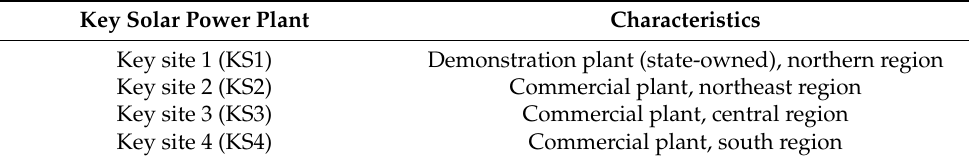
Table 4. Key solar power plants for structured interviews.